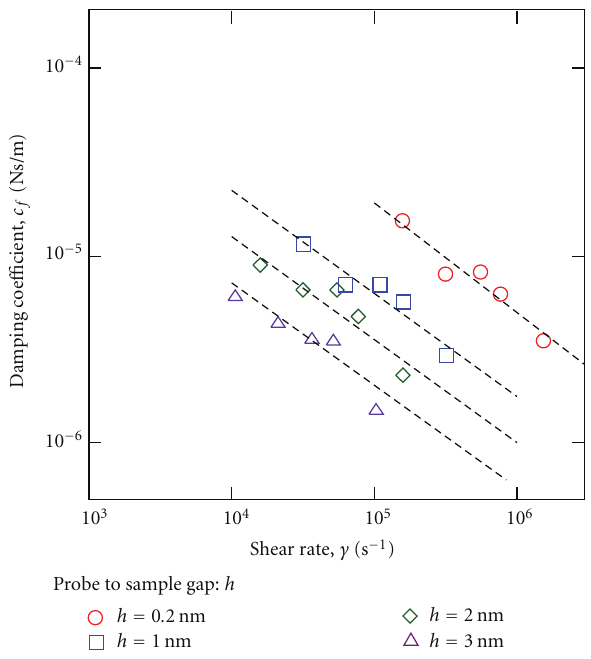
Figure 16: The relationship between the shear rate and viscous coe ffi cient, c f